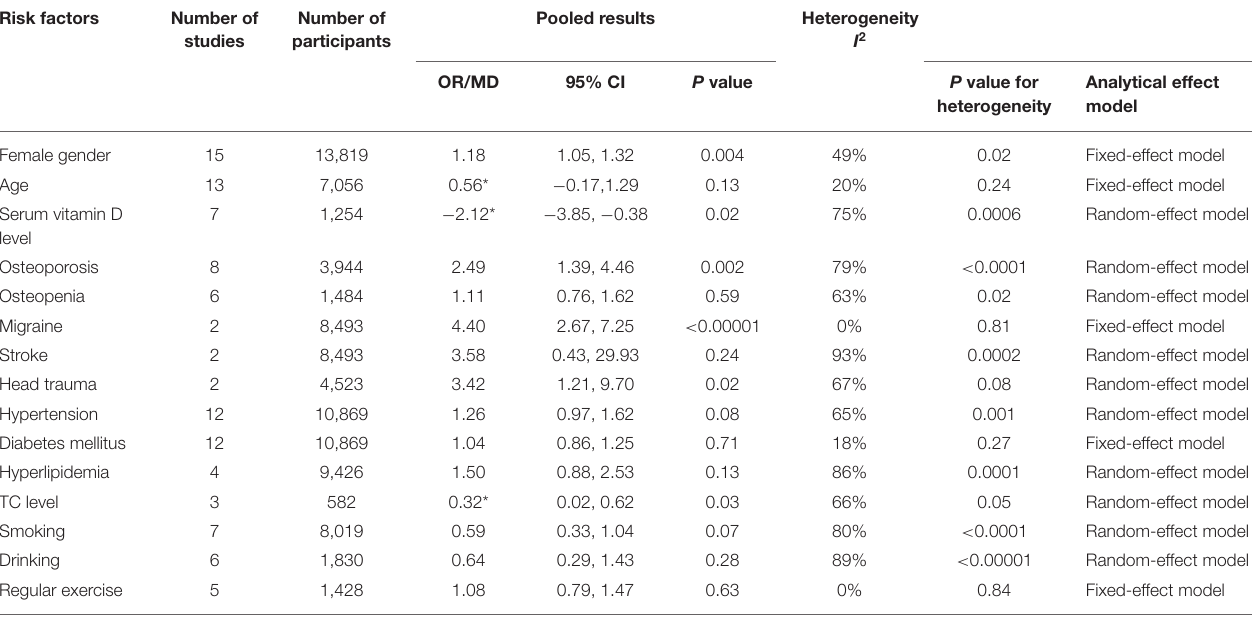
TABLE 2 | The pooled results for each risk factor included in this